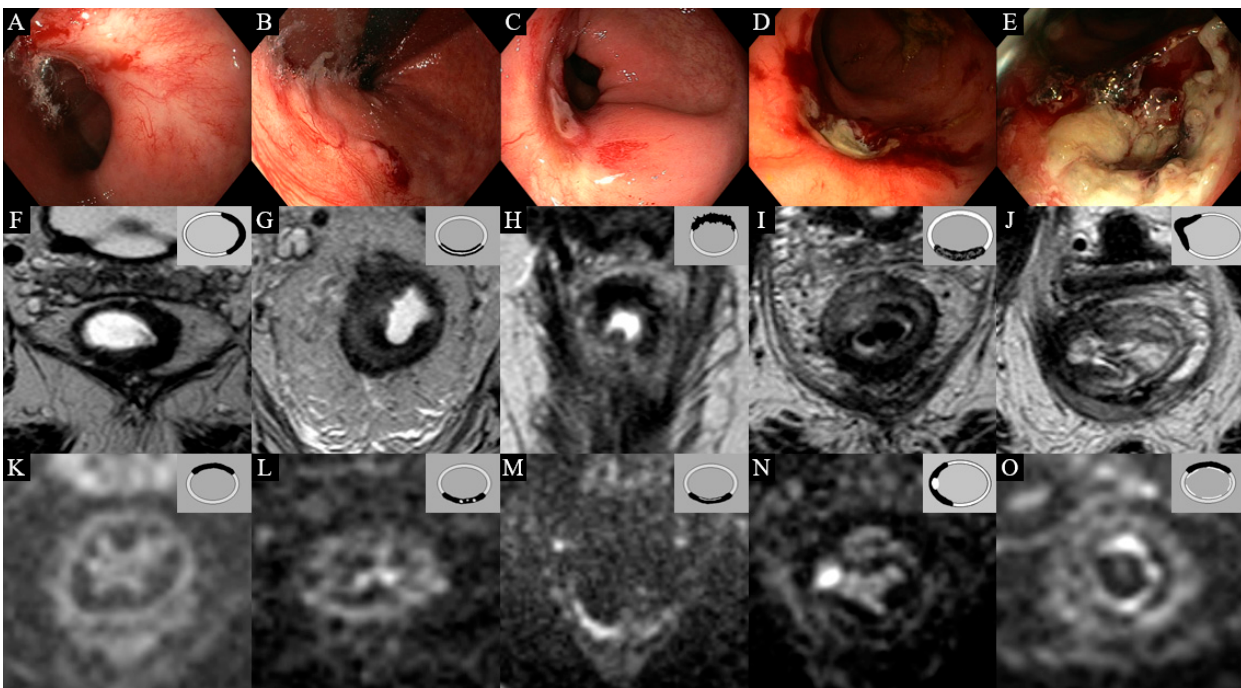
Figure 1. Features on endoscopy, T2W ‐ MRI, and DWI. ( A ) Flat, white scar on endoscopy; ( B ) adenomatous tissue on endoscopy; ( C ) ulcer with regular borders on endoscopy; ( D ) ulcer with irregular borders on endoscopy; ( E ) tumor mass on endoscopy; ( F ) regular homogeneous fibrosis on T2W ‐ MRI; ( G ) layered fibrosis on T2W ‐ MRI; ( H ) irregular fibrosis on T2W ‐ MRI; ( I ) heterogeneous fibrosis on T2W ‐ MRI; ( J ) ulceration on T2W ‐ MRI; ( K ) no high signal on DWI; ( L ) small spots of high signal on DWI; ( M ) linear high signal on DWI; ( N ) mass ‐ like high signal on DWI; ( O ) a diffuse “reactive” mucosal diffusion signal on DWI.